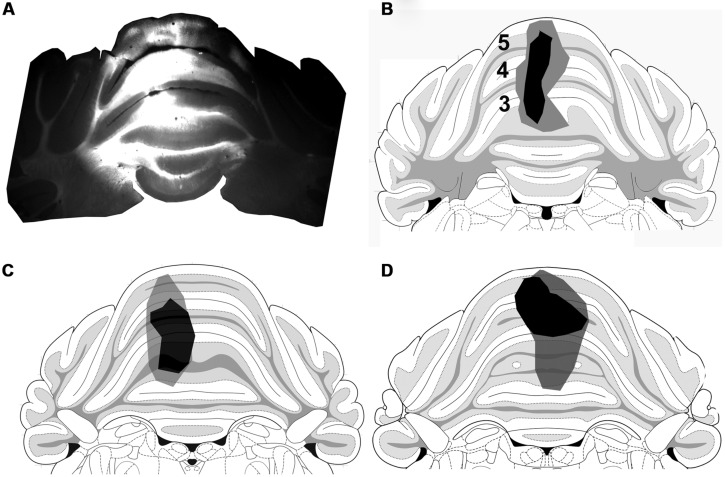
Cerebellum injection sites.
(A) A fluorescence micrograph showing a FG injection site within a coronal section of the anterior cerebellum. (B–D) Drawings of the core (black) and spread (gray) of FG within lobules 3, 4, and 5 of animals 1–3, respectively, (based on Paxinos and Watson, 2005).